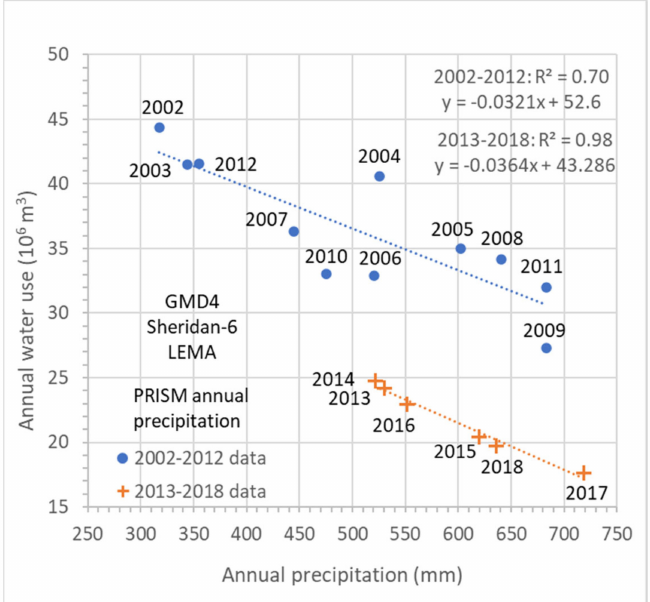
Figure 2. Water use vs. precipitation 2002–2018 for Sheridan-6 LEMA. Source: data for Figure 5 in Butler et al.